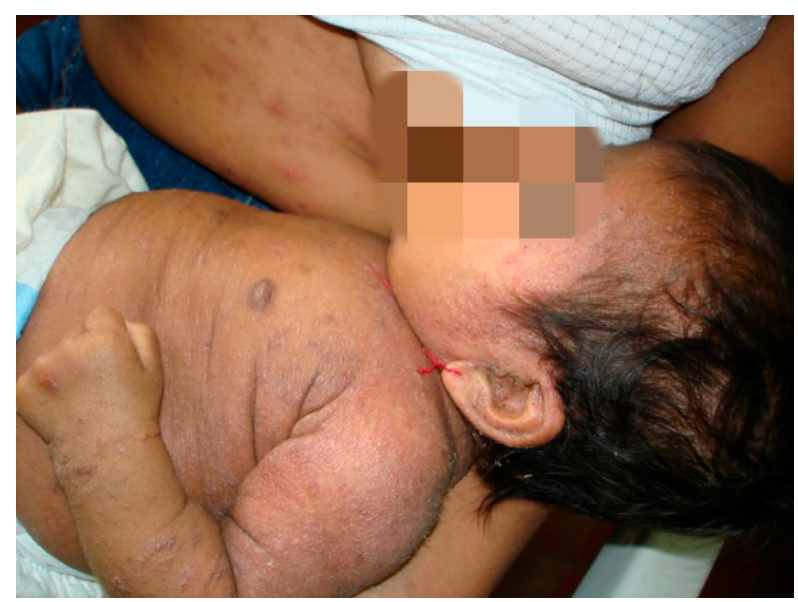
Figure A3. Crusted scabies with intense scaling and nodular lesions in child and mother with scabies.